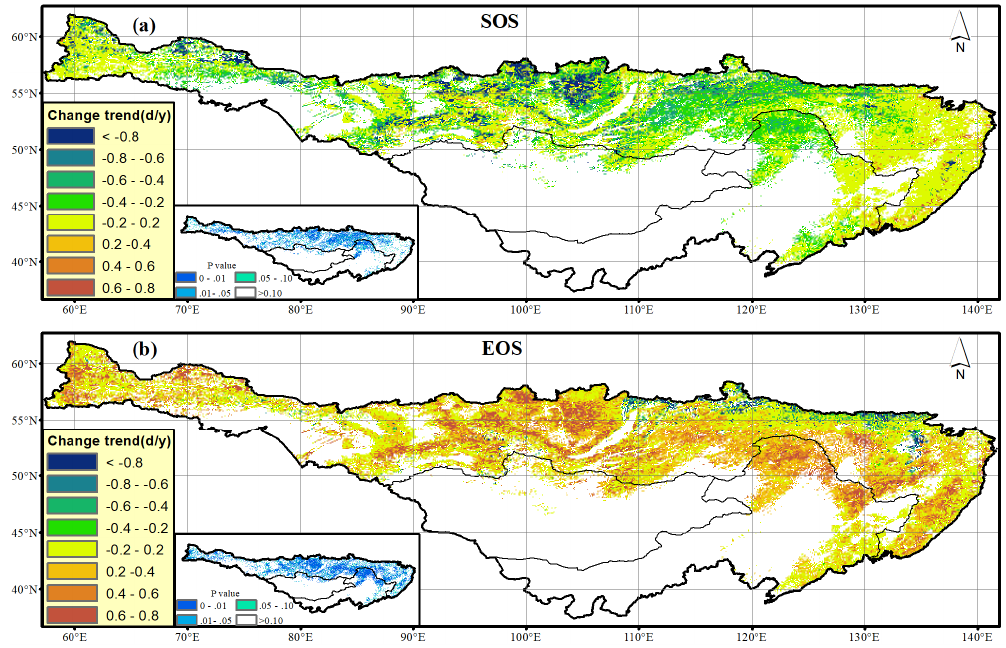
Figure 3. Spatial distribution of change trend in start date of the growing season (SOS, a ) and end date of the growing season (EOS, b ) from 1982 to 2015 in the China–Mongolia–Russia International Economic Corridor. The bottom left inset shows the pixels with significant ( p < 0.1, p < 0.05 and p < 0.01) SOS or EOS change.